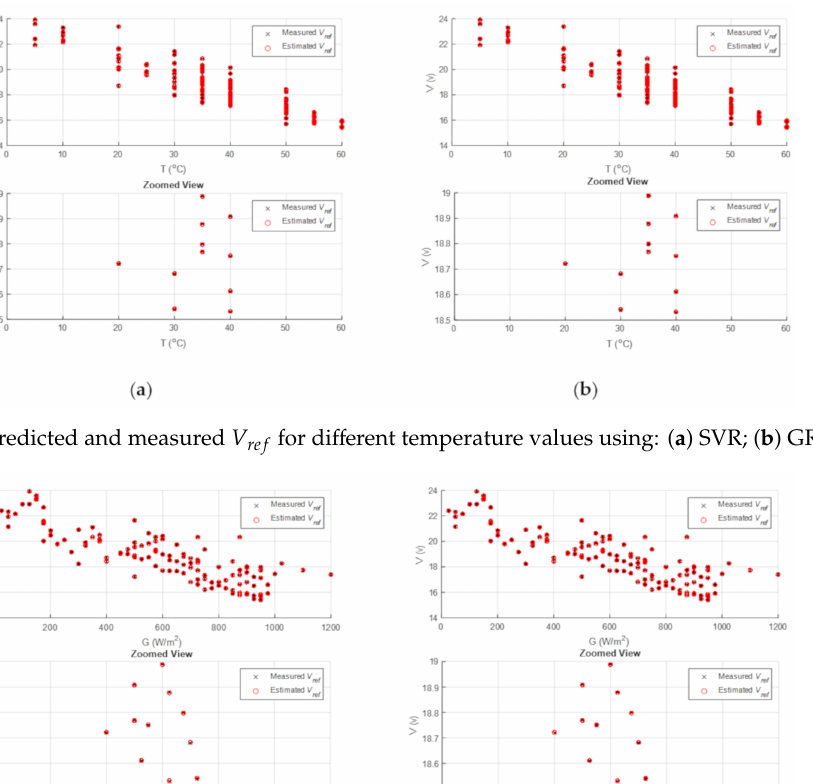
Figure 7. Surface power-temperature-voltage characteristics of maximum power point (MPP).